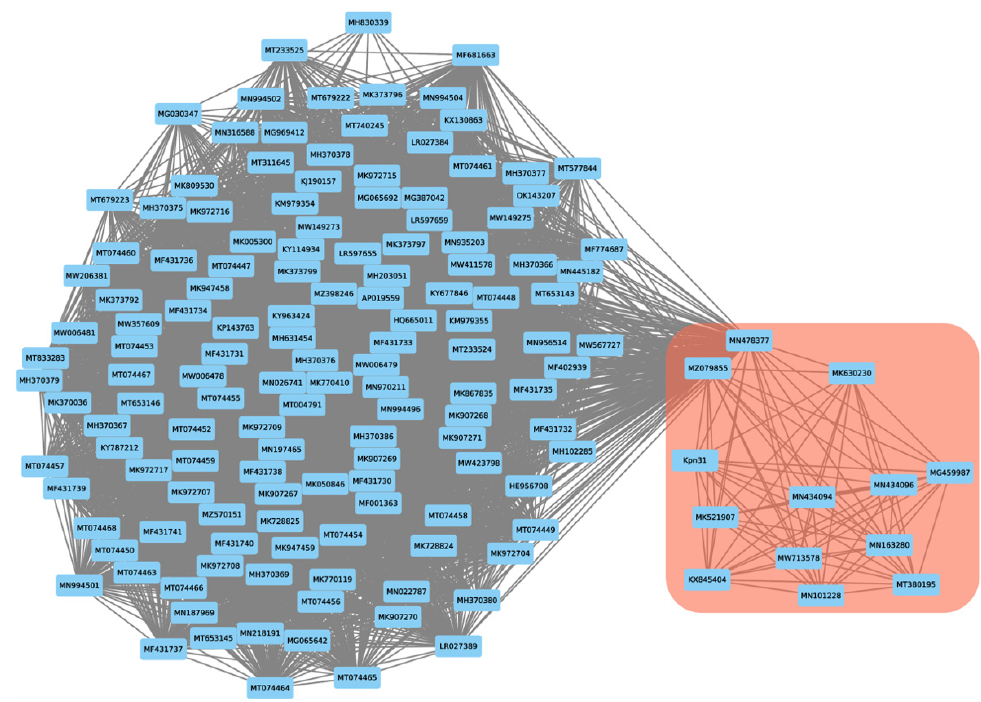
Figure 4. Proteome-based network analysis calculated with vConTACT2. The predicted proteome of phage Kpn31 was clustered with the proteome of its closest 233 annotated phages pre-selected from the Millard phage database. The Kpn31 cluster encompassing the 12 phages listed in Table 2 is highlighted by a red box. The numbers in the nodes correspond to the NCBI accession of each phage genome. The edges between nodes represent shared proteins. Table 2. Phages that clustered together with phage Kpn31 in the network analysis performed. Table 3. Host range of phage Kpn31 determined on 39 bacterial strains. Numbered strains of K. pneumoniae were derived from clinical isolates from human patients (see Supplementary Table S3 for antibiotic susceptibility profile). Clear lysis zone (+) and no-lysis zone ( − ) on the spot tests. An efficiency of plating (EOP) value of 100% was considered for the host strain K. pneumoniae CCCD—K001. n.d.—not